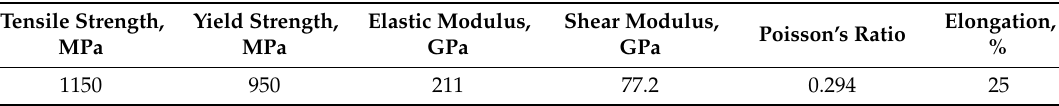
Table 1. Mechanical properties of Alloy 718.